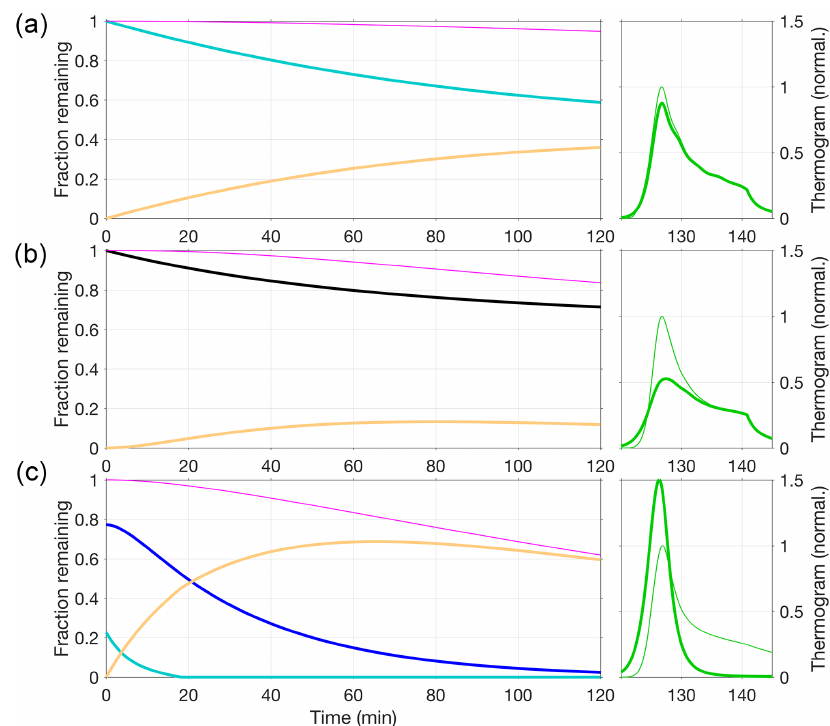
Figure 14. Simulations of a 2h period of isothermal evaporation of C 8 H 12 O 5 at room temperature (left-hand panels) and the subsequent thermograms (right-hand panels). Input parameters for (a) , (b) , and (c) are identical to those for Figs. 9, 10, and 11, respectively. The thick lines in the left-hand panels show the fractions of monomers remaining in various states as indicated by the color scheme. Light blue fractions (a, c) are monomers in the particle and free to evaporate, the dark blue fraction (c) is monomers bound in a non-volatile (oligomer) state initially in steady state with the free monomers, the black fraction (b) are monomers in a pre-defined distribution of thermally decomposing non-volatile compounds (black), and the orange fractions are monomers already desorbed from the particle but adsorbed to surfaces. The thin magenta lines are the respective sums, equal to the fraction of monomers not yet sampled by the CIMS. The right-hand panels show the simulated thermograms obtained following the 2h isothermal evaporation period (thick green lines), normalized to the maximum of the thermogram obtained without the 2h period (shown by the thin green